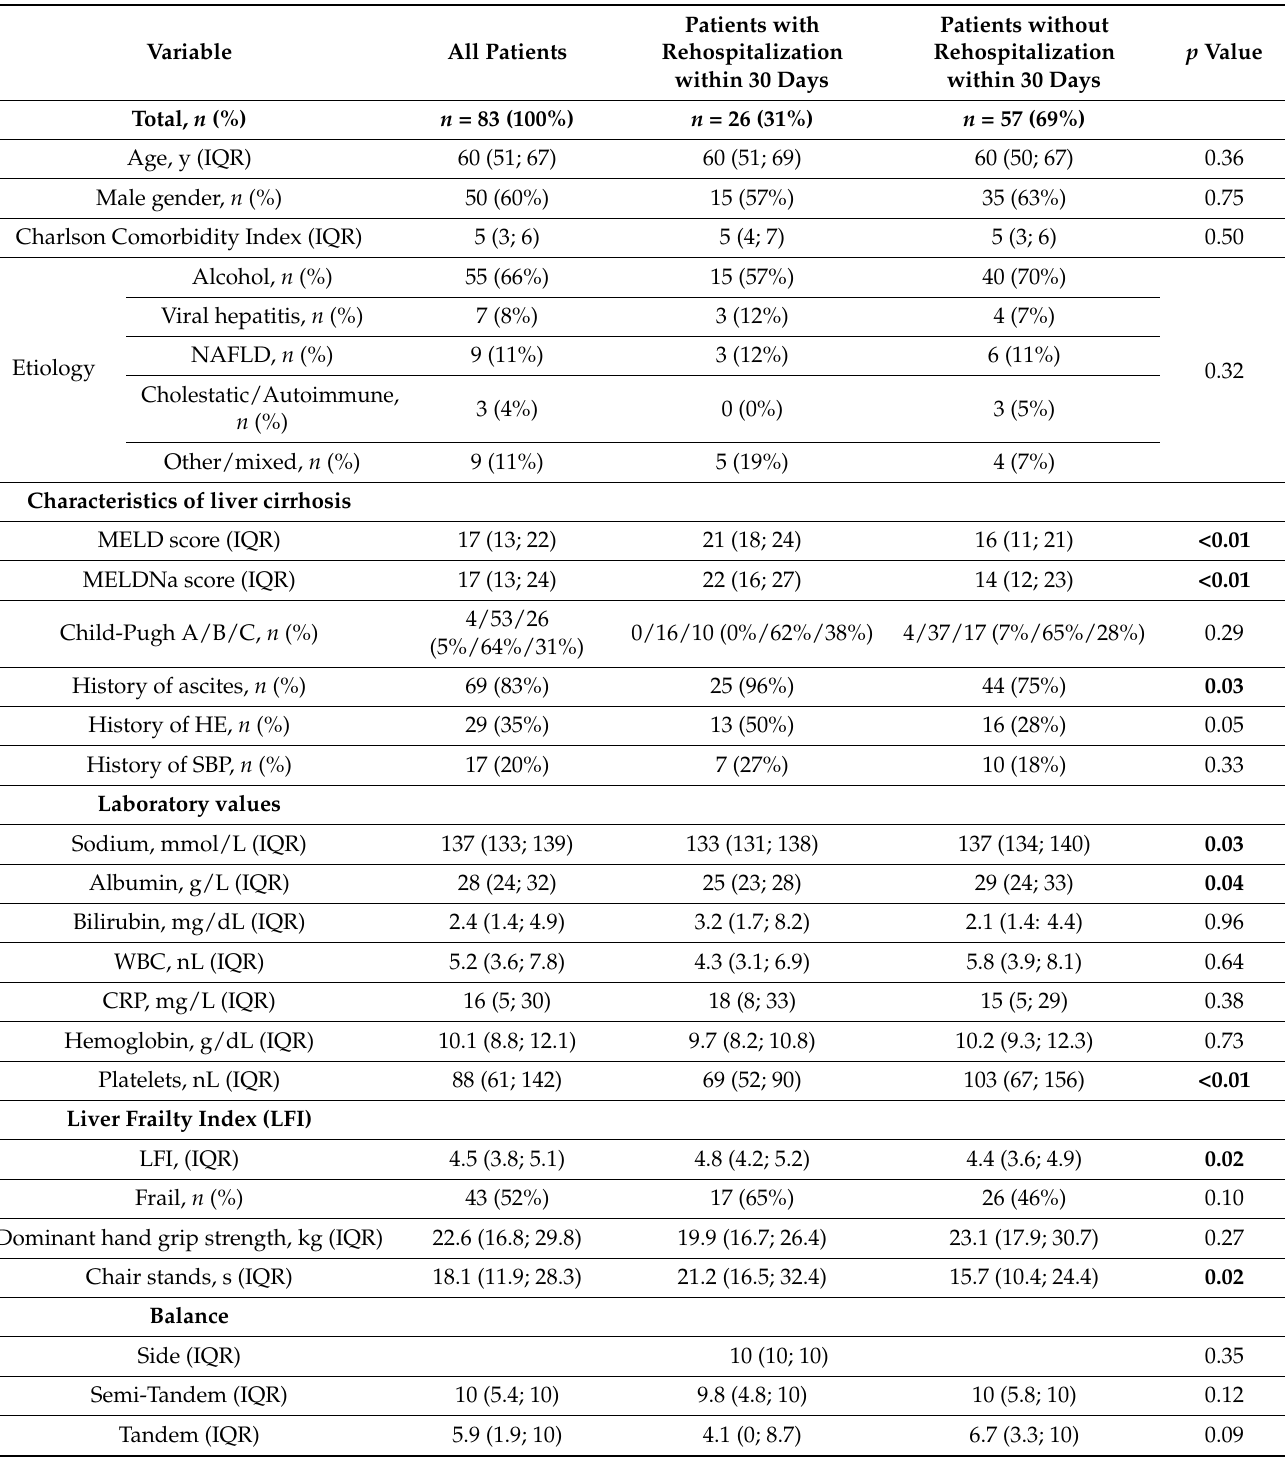
Table 1. Baseline characteristics of the entire cohort at study inclusion and comparison between patients with and without rehospitalization within 30